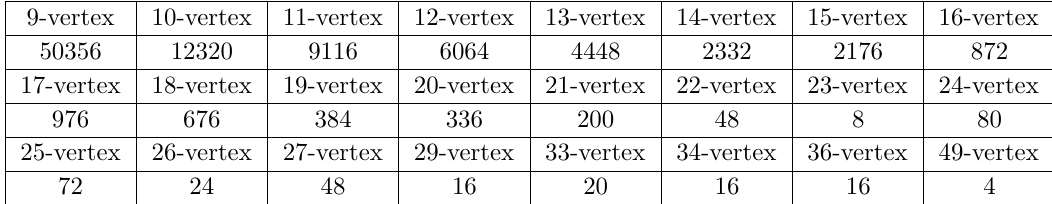
Table 4 . The numbers of various types of vertices of P (4 ; 8), classi(cid:12)ed by the number of facets adjacent to each